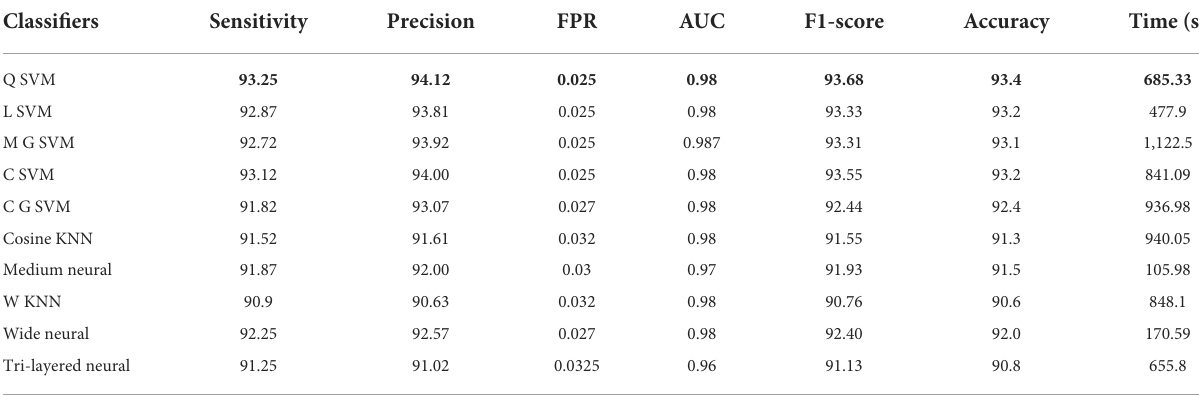
TABLE 2 Proposed features fusion method results on COVID-19 Radiography